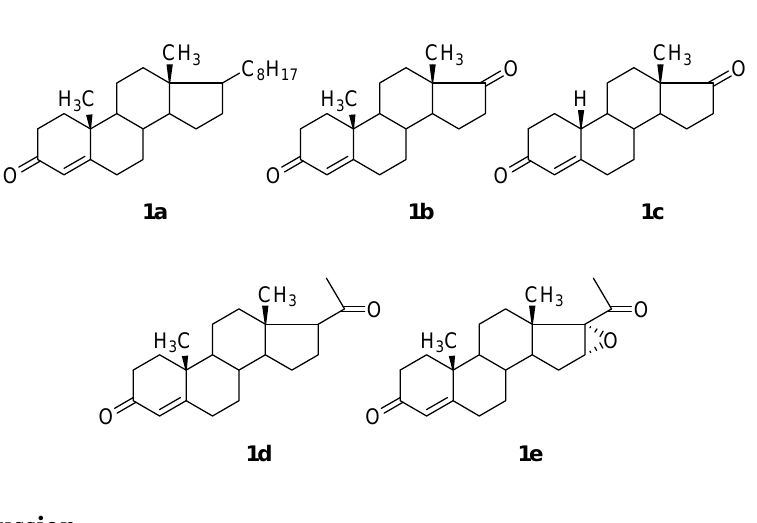
Figure 2. Substrates 1a-e